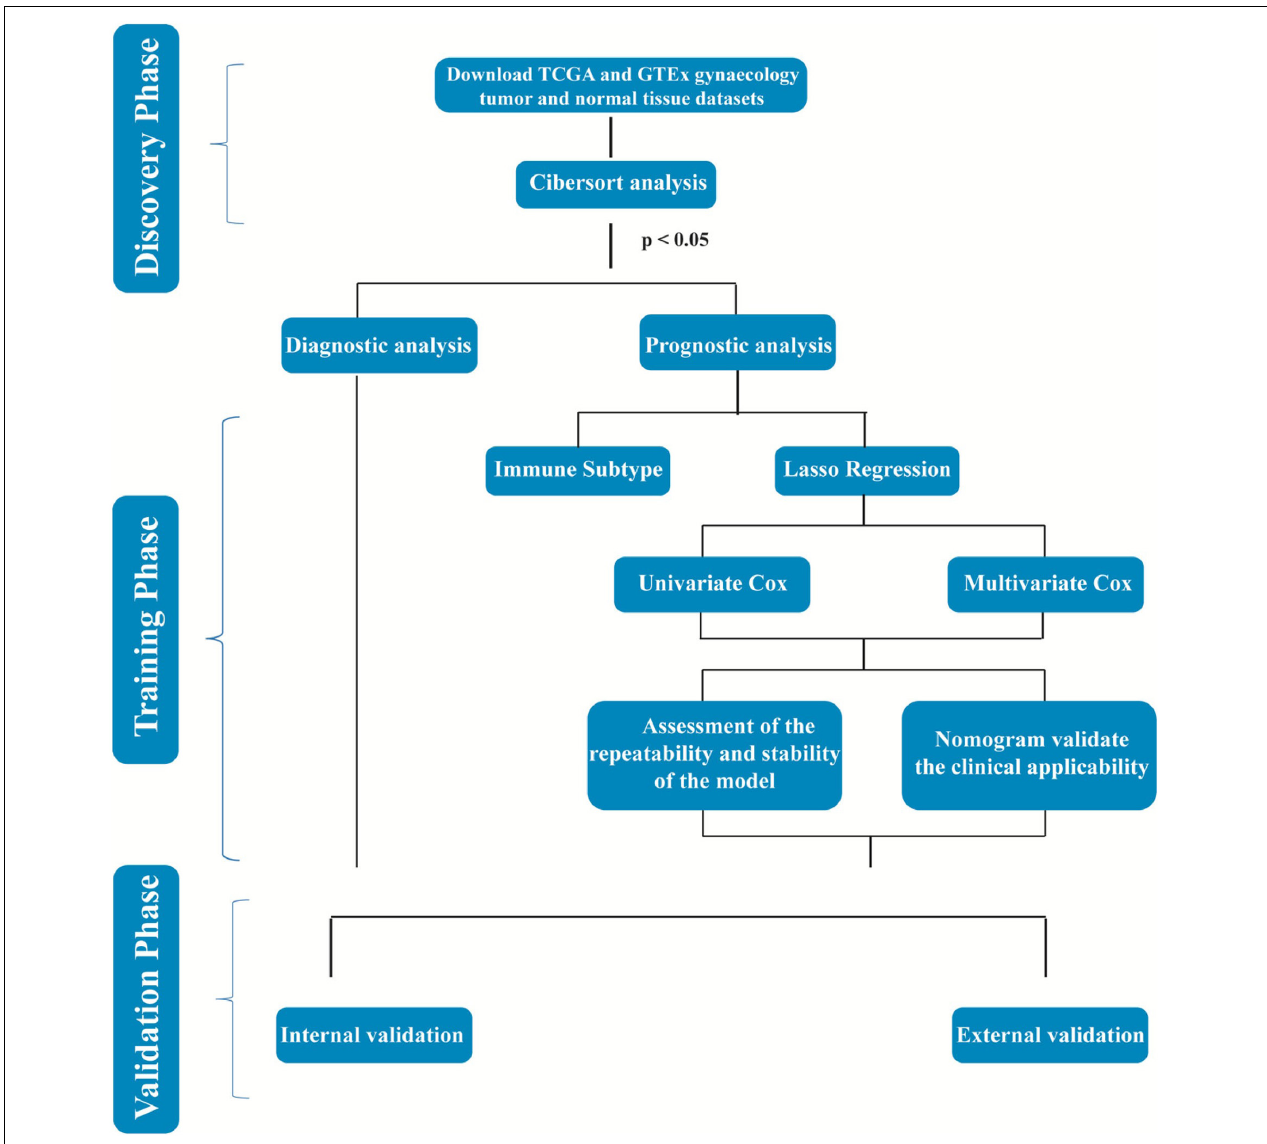
FIGURE 1 | Workflow chart of data generation and